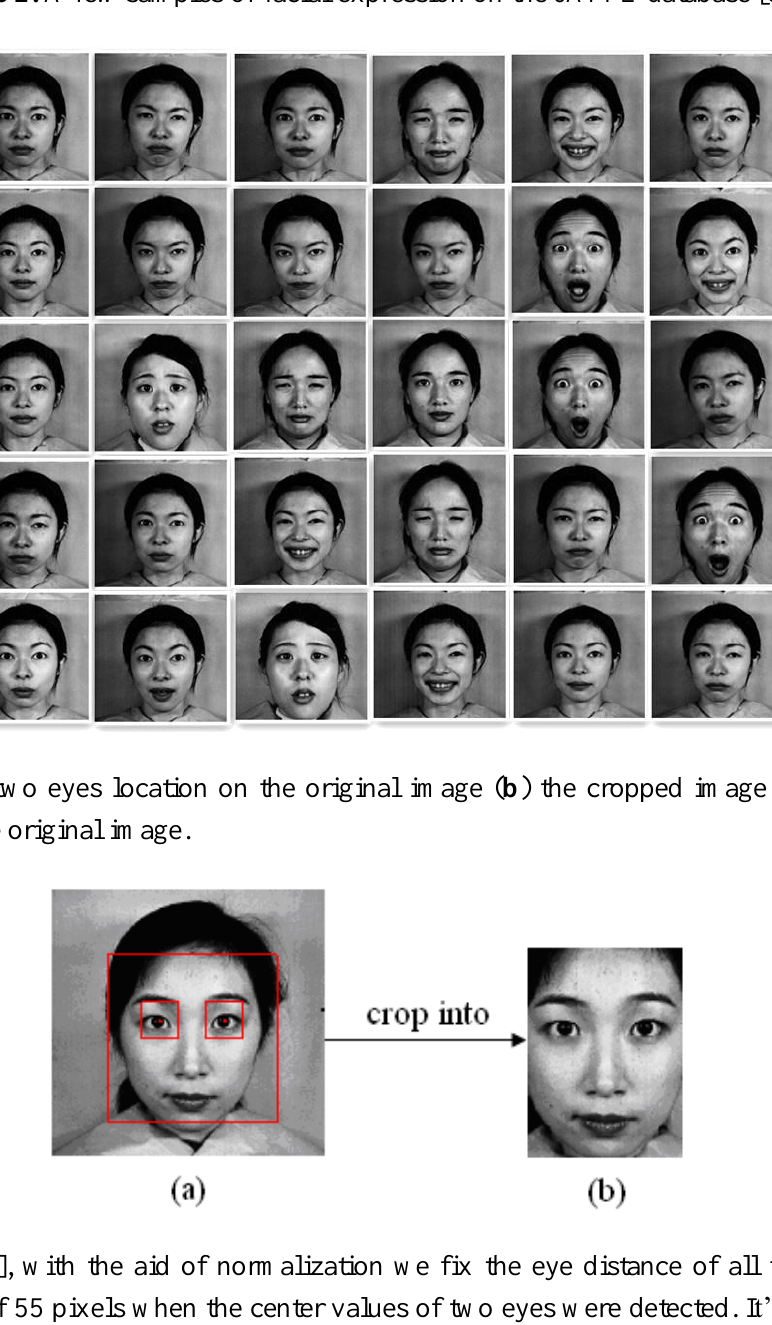
Figure 2. A few samples of facial expression on the JAFFE database [35].